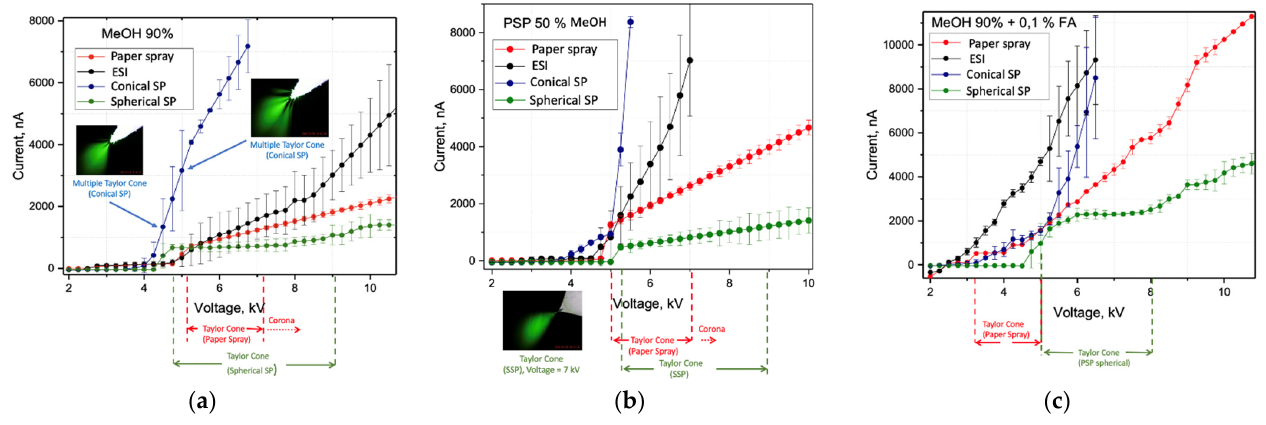
Figure 2. Electrospray current as a function of applied voltage in the range 2–10.5 kV for different solvents (positive ion mode): ( a ) 9:1 ( v / v ) MeOH: H 2 O; ( b ) 1:1 ( v / v ) MeOH: H 2 O; ( c ) 9:1 ( v / v ) MeOH: H 2 O + 0.1% FA ( v / v ). The distance between the tip of the ion source and the counter electrode is 10.0 mm, angle 30 ◦ .